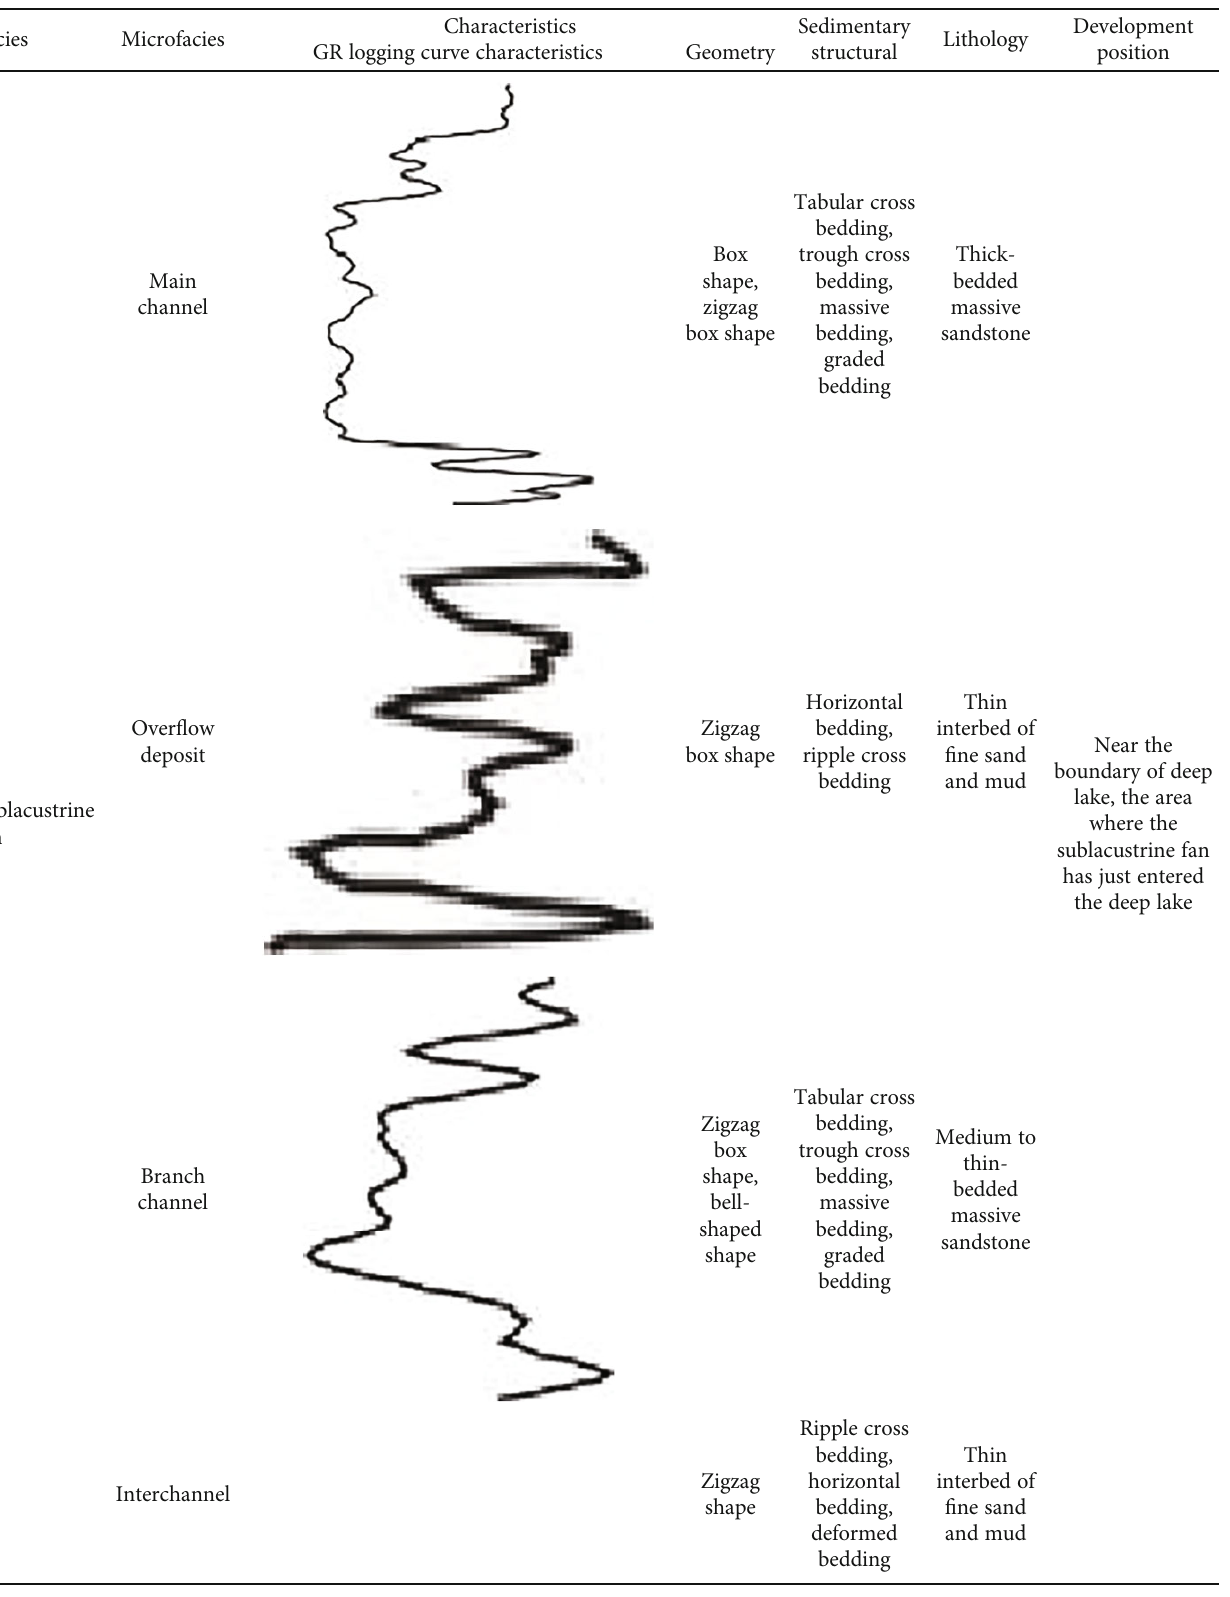
Table 1: The characteristics of log facies of di ff erent sedimentary facies in the study